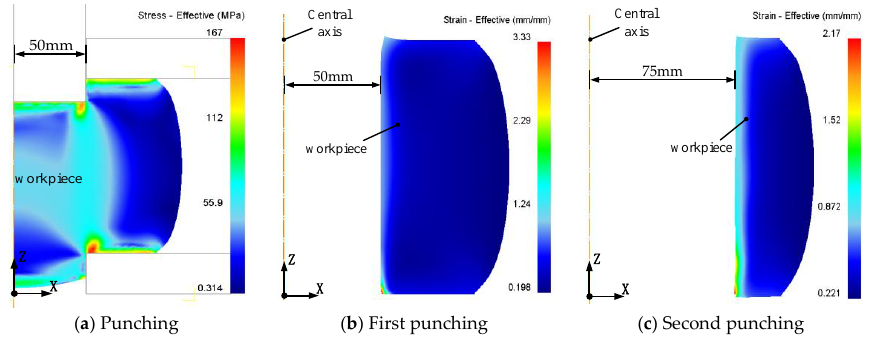
Figure 3. Stress and strain during punching.